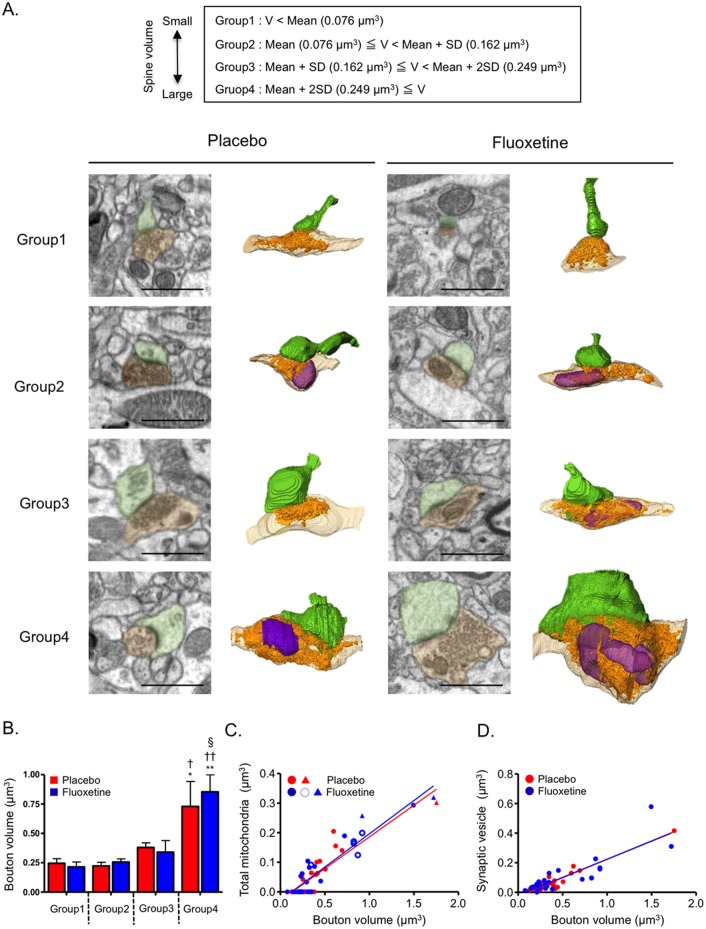
Characterization of presynaptic boutons connected to spines of different sizes.(A) Presynaptic boutons were classified by their connections to spines with different sizes. The spines were subdivided into four groups (Groups 1–4) based on the mean and SD values of the spine volume in placebo-treated mice. Typical images of SEM and 3D reconstructed spines (green) and connected boutons (light brown) are shown. Synaptic vesicles (orange) and mitochondria (purple) are shown inside the presynaptic boutons. Scale bars: 1 μm. (B) Volume of presynaptic boutons connected to spines classified as Groups 1–4. n = 6–10 presynaptic boutons in each group. No significant difference between placebo and fluoxetine with two-way ANOVA (drug effect, F(1,44) = 0.0682, p < 0.794; group effect, F(3,44) = 11.5, p < 0.0001; drug and group interaction, F(3,44) = 0.230, p = 0.875). One-way ANOVA: placebo, F(3,20) = 4.48, p = 0.0147; fluoxetine, F(3,24) = 7.81, p = 0.0008; Bonferroni’s post-hoc test, *p < 0.05, compared with Group 1 in placebo, †p < 0.05 compared with Group 2 in placebo, **p < 0.01 compared with Group 1 in fluoxetine, ††p < 0.01 compared with Group 2 in fluoxetine, §p < 0.05 compared with Group 3 in fluoxetine. (C) Correlation between volumes of mitochondria and presynaptic boutons in mice treated with placebo (r2 = 0.79, p < 0.0001) or fluoxetine (r2 = 0.84, p < 0.0001) with linear regression analysis. The symbol indicates the number of mitochondrion in each presynaptic bouton: ●, one; ○, two; ▲, three. The mitochondrial volume is the sum of the volume for all of the mitochondria in each bouton. (D) Correlation between the volumes of synaptic vesicles and presynaptic boutons in mice treated with placebo (r2 = 0.91, p < 0.0001) or fluoxetine (r2 = 0.72, p < 0.0001) with linear regression analysis.